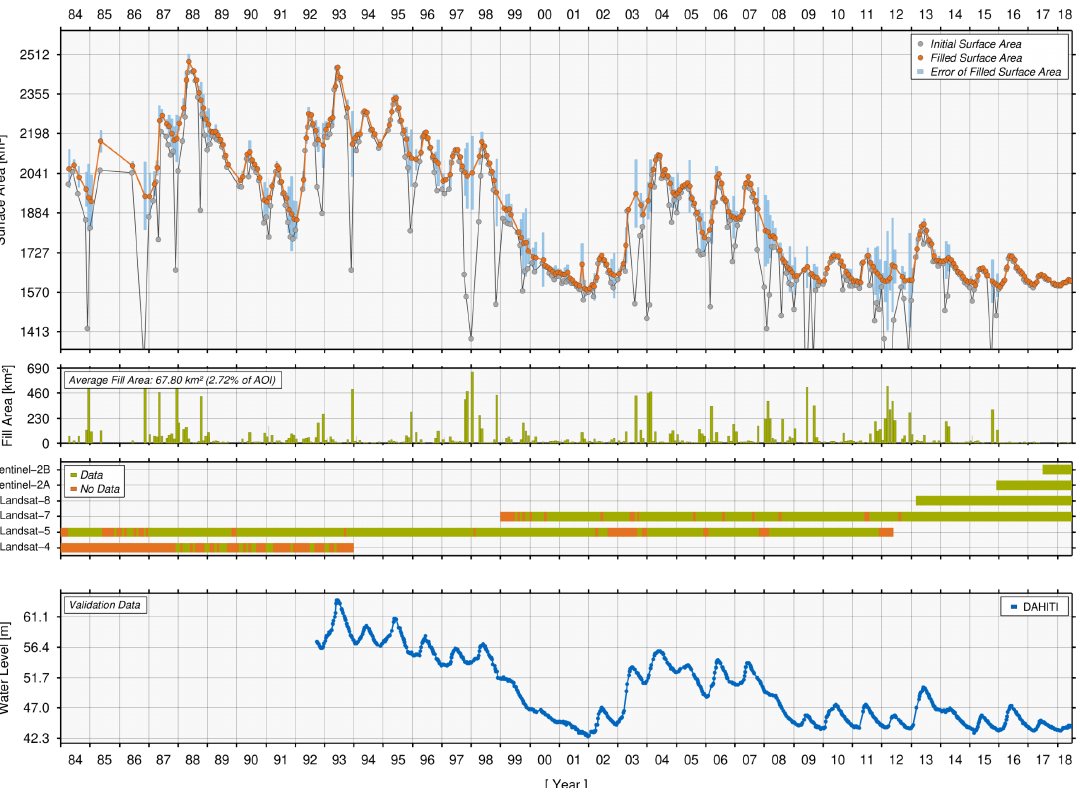
Figure 19. Water surface area time series (orange) and its errors (blue) of Tharthar Lake. Additionally, the initial surface area with data gaps (gray) and the filled area (green) are shown. Also, the data availability of monthly optical images from Landsat and Sentinel-2 are presented. Finally, the water level time series from DAHITI which is used for validation is shown.